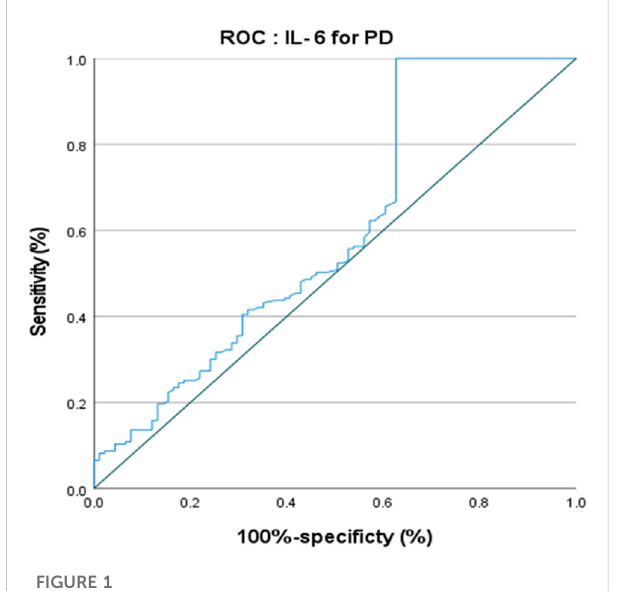
ROCcurveofIL-6combinedwithTNF- α forthediagnosis